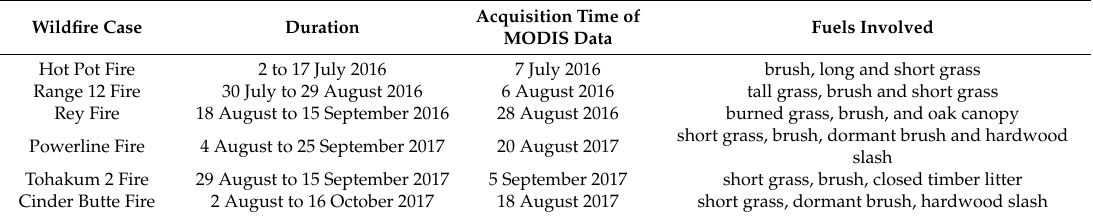
Figure 1. The geographic location and the false-color composition RGB images of MODIS bands 7, 5 and 6 of the six wildfire cases. Table 2. Detailed information of the wildfire cases and acquisition time of MODIS data.